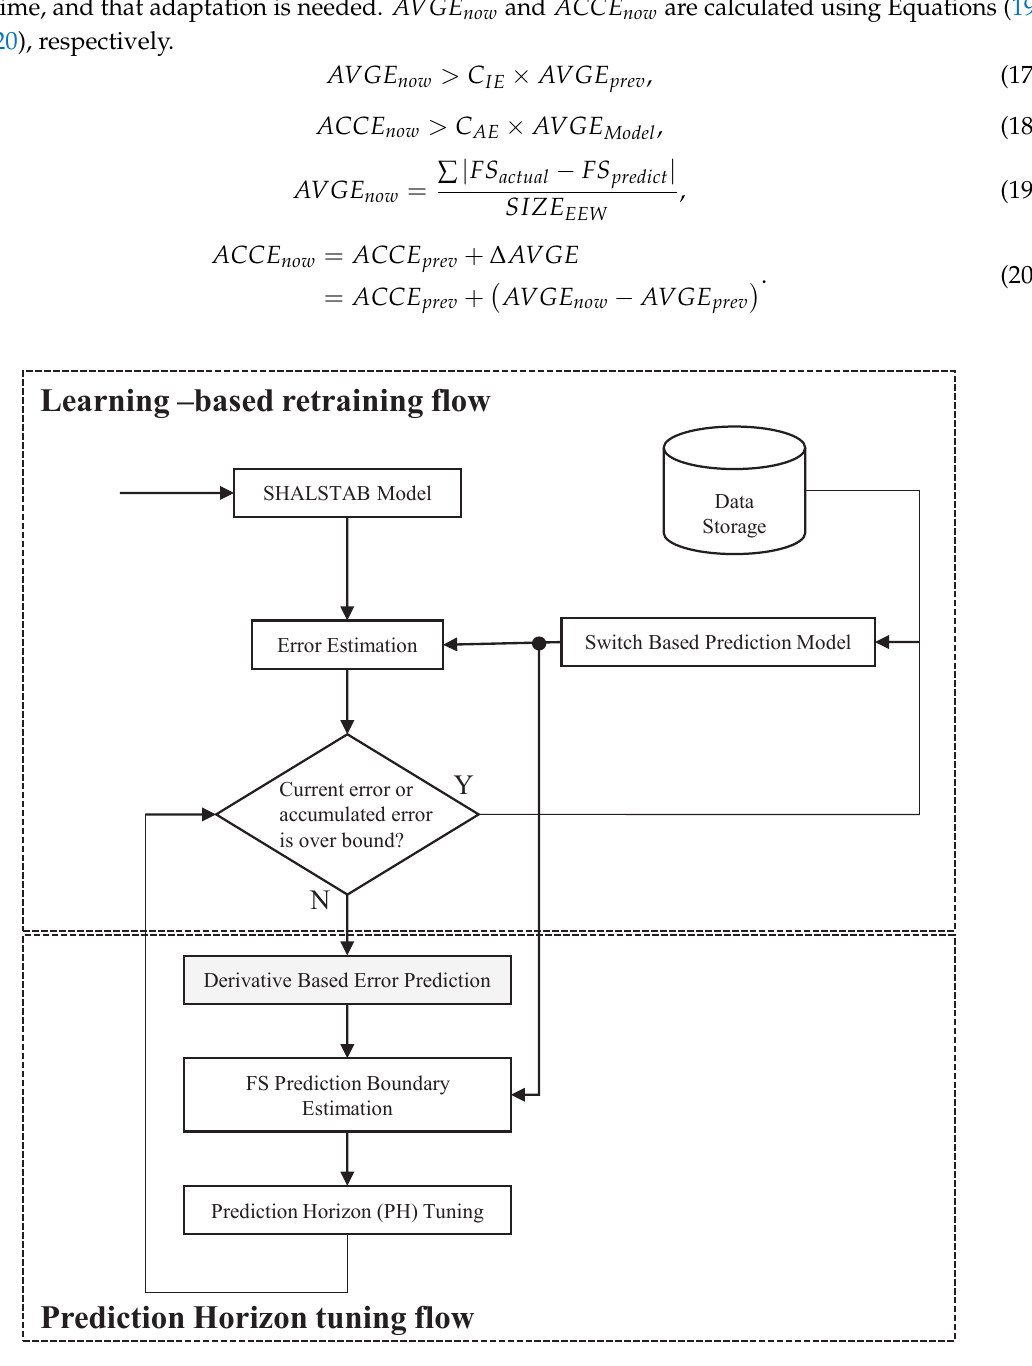
Figure 7. Overall Flowchart of Prediction Model